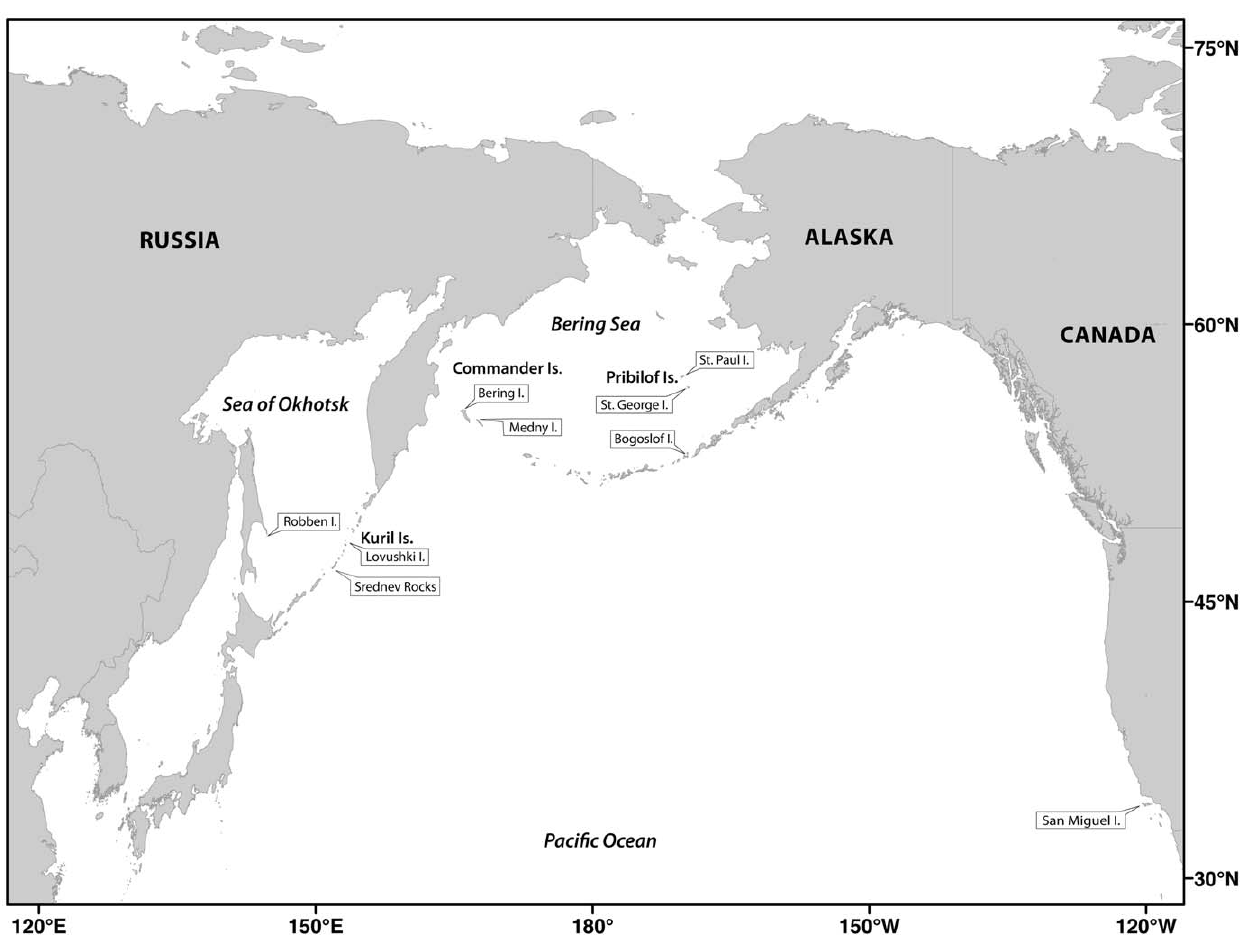
Figure 1. Distribution of northern fur seal breeding sites.